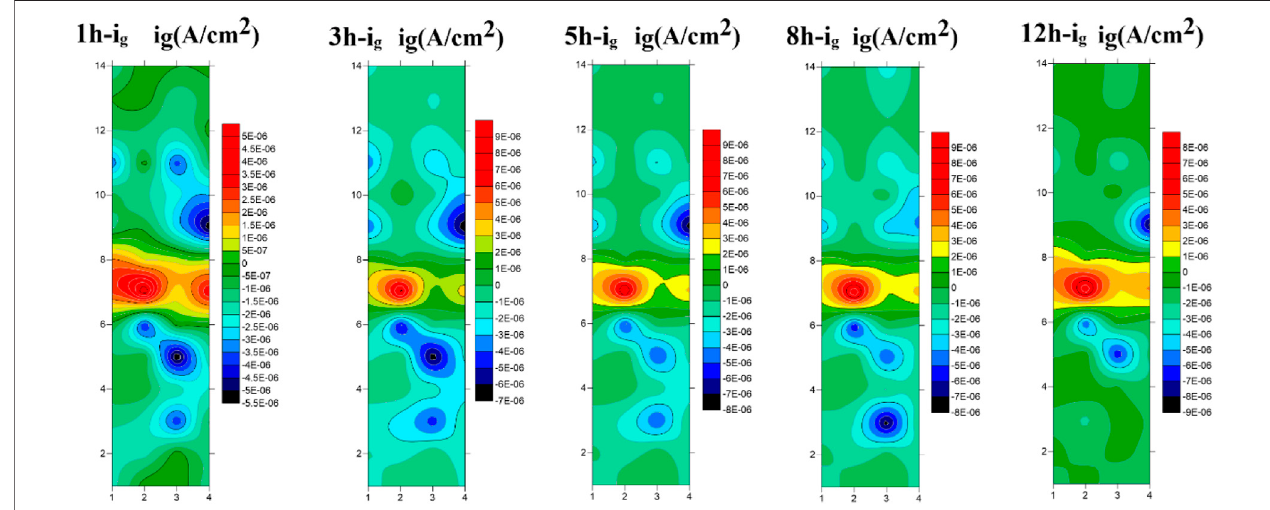
FIGURE 14 | WBE test results at 3 m/s fl ushing for 12 h after zonal coupling of welded joints.